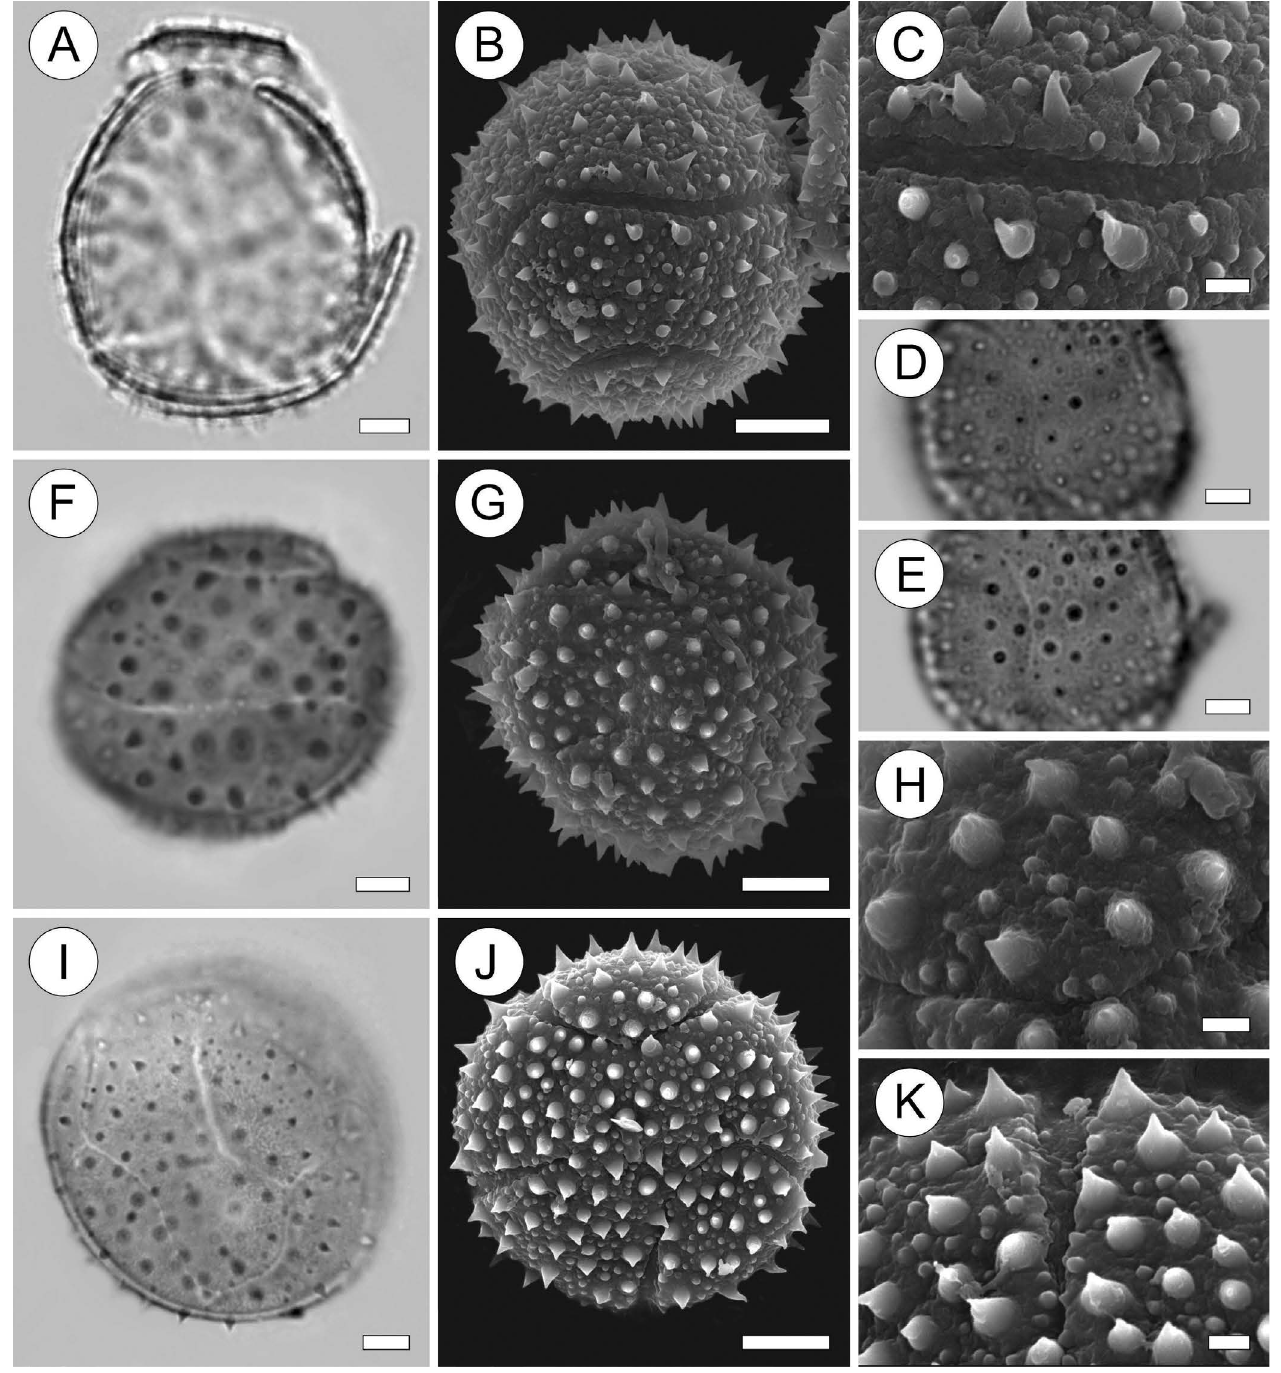
Figure 3 – Pollen morphology of Paepalanthus decumbens and related species. A–E, P. decumbens (from Picanço et al. 69, R); F–H, P. microphyllus (from Giordano & Toscano 687, RB).; I–K, P. stannardii (from Mori et al. 12539, RB). A, optical section; B, grain, showing the spiraled aperture (SEM); C, detail of aperture and sexine surface (SEM); D, high focus of microreticule and supratectal microelements; E, low focus of microreticulate sexine surface and supratectal microelements; F, low focus showing the apertural pattern and ornamented membrane; G, general view showing the spiroaperture and the ornamentation (SEM); H, detail of the ornamentation; I, low focus showing the microreticule and a random conformation of the aperture; J, general view of the whole grain with an incomplete loop of the aperture in the middle of the grain (SEM); K, detail of the ornamentation and the aperture with an ornamented membrane. Scale bars: A, B, D–G, I & J = 5 µm; C, H & K = 1